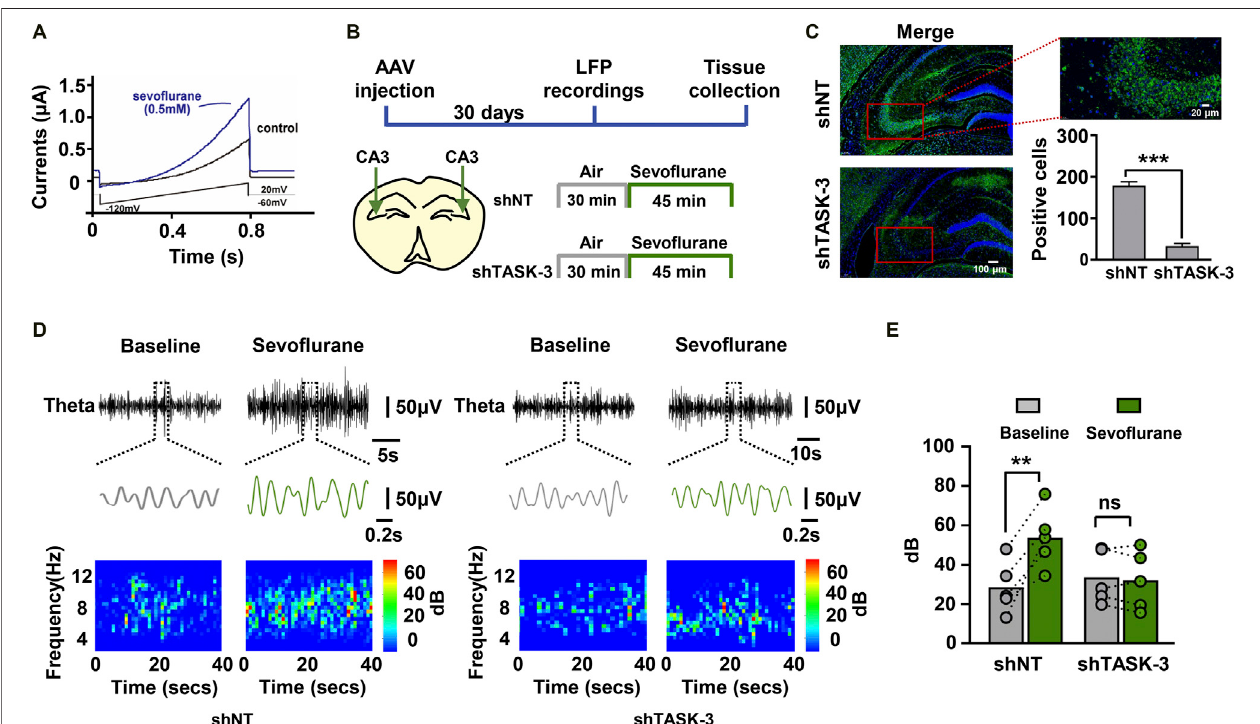
FIGURE 4 | TASK-3 channels mediate the enhancing effect of sevo fl urane on theta oscillations. (A) Representative time course of whole-cell current during sevo fl urane (0.5 mM) application. The TASK-3 construct was transfected into HEK293 cells and ramp voltage commands were used to elicit the TASK-3 current. ( B ) Timeline of experiment. In vivo electrophysiological recording was conducted after stable expression of adeno-associated virus (AAV) in mice. (C) Representative immuno fl uorescence images of TASK-3 channels (green) in the hippocampus of both control and TASK-3 knockdown mice. Scale bar, 100 μ m in left images. Scale bar, 20 μ m in right image. Quanti fi cation of TASK-3 antibody-labeled cells in the hippocampal CA3 region from mice with both phenotypes. (D) Examples of theta wavesandrepresentativespectrogramsrecordedatimmobilestatusduringsevo fl uraneanesthesiafromcontrol (left) andTASK-3knockdown (right) mice. (E) Thetotal power of theta rhythms from control and TASK-3 knockdown mice before and during sevo fl urane anesthesia. N (cid:2) 5/group. Values are shown as the mean ± SEM. Unpaired t-tests shown in ( C ); paired t-tests shown in ( E ). ** p < 0.01, *** p < 0.001.